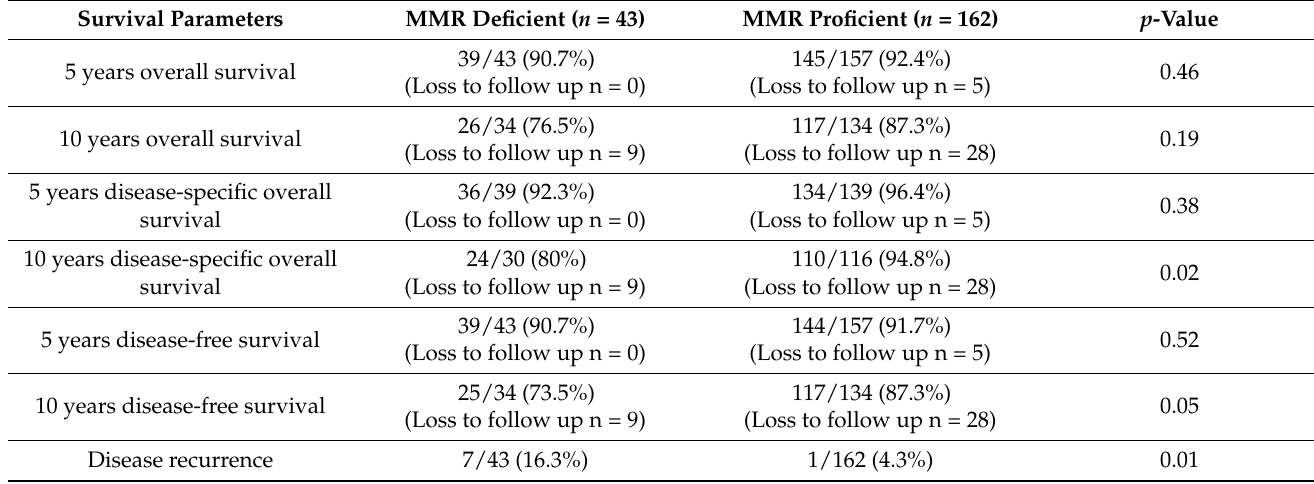
Table 4. MMR status in association with survival